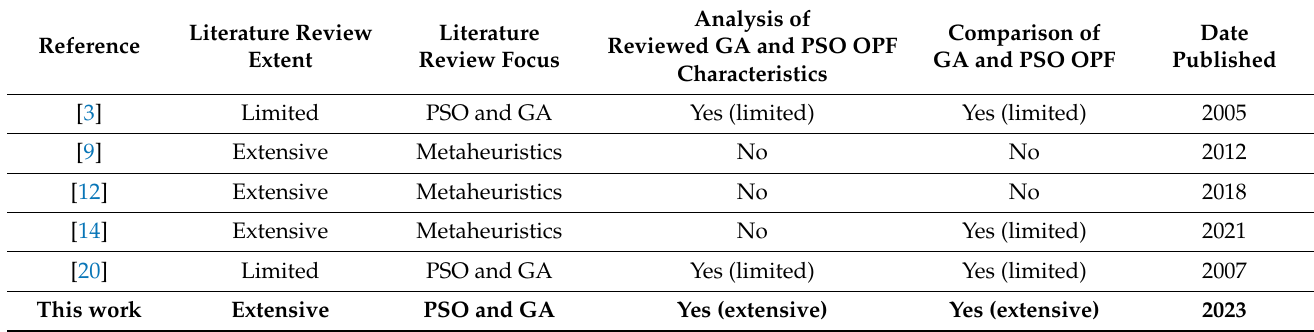
Table 1. Comparison between this work and similar